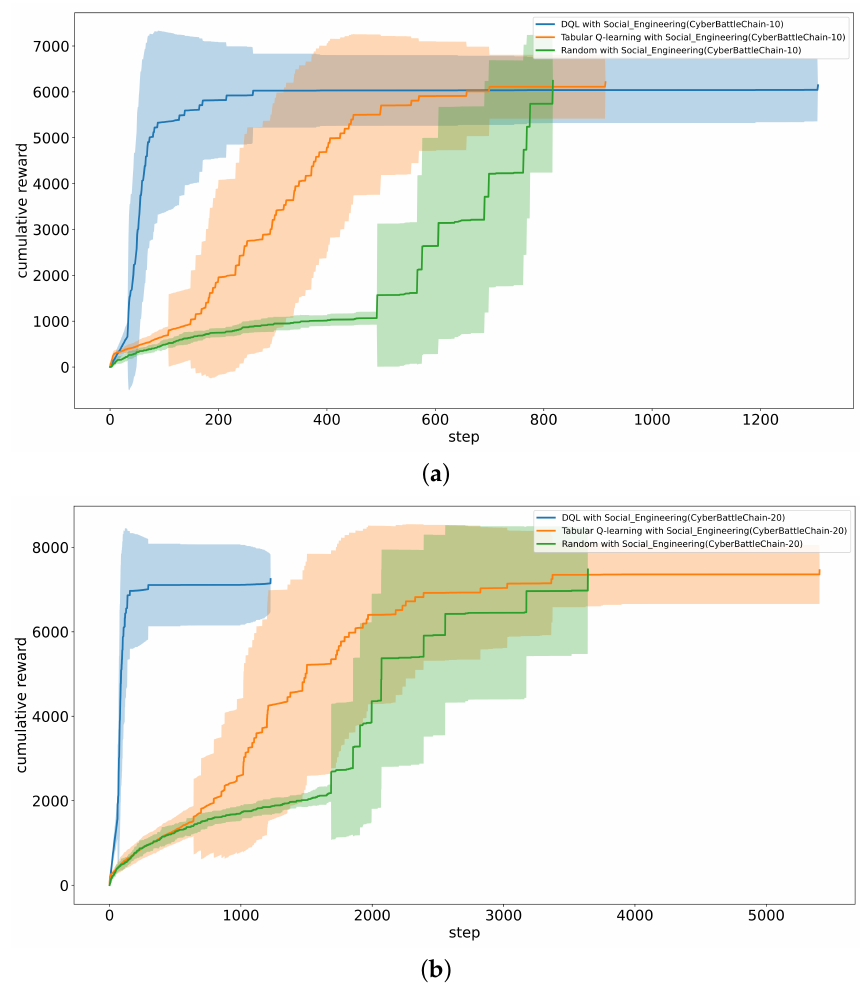
Figure 13. The result of experiment B. ( a ) Average cumulative reward variation for three agents trained in the CyberBattleChain-10 scenario. ( b ) Average cumulative reward variation for three agents trained in the CyberBattleChain-20 scenario. Table 6. Hyperparameter settings of Experiment